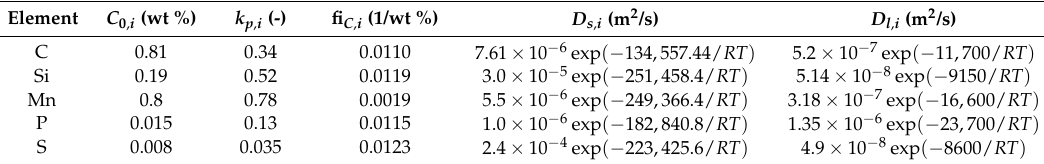
Table 2. Chemical compositions and corresponding coefficients.